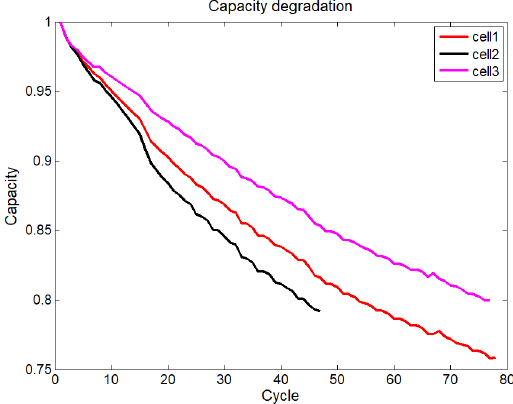
Figure 2. The measured capacity of raw data.